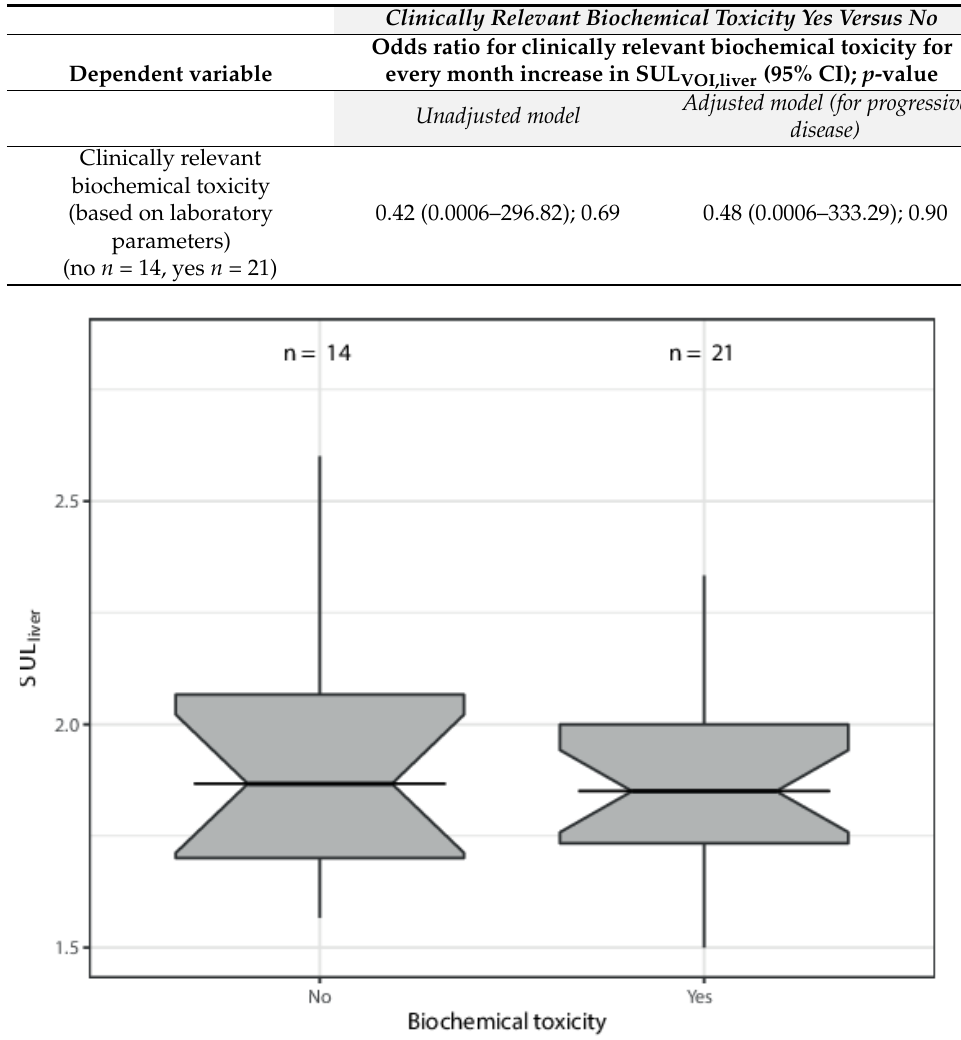
Figure 3. Differences in SUL liver (patient-level) versus biochemical toxicity. Numbers represent the different durations of biochemical toxicity determination per patient. Some patients had measurements at two follow-up times so numbers do not equal total number of patients. For SUL blood , no significant increase or decrease over time was found; the mean change in SUL blood per month increase in time was − 0.012 (95%CI − 0.05–0.03) at p = 0.57 (Figure 4A). SUL spleen was also stable over time; the mean change per month increase over time was 0.005 (95%CI − 0.04–0.05) at p = 0.83 (Figure 4B), while the splenic volume did not significantly increase over time. There was a 49 mL increase in volume per month (95%CI 32–65, p = 0.0011) (Figure